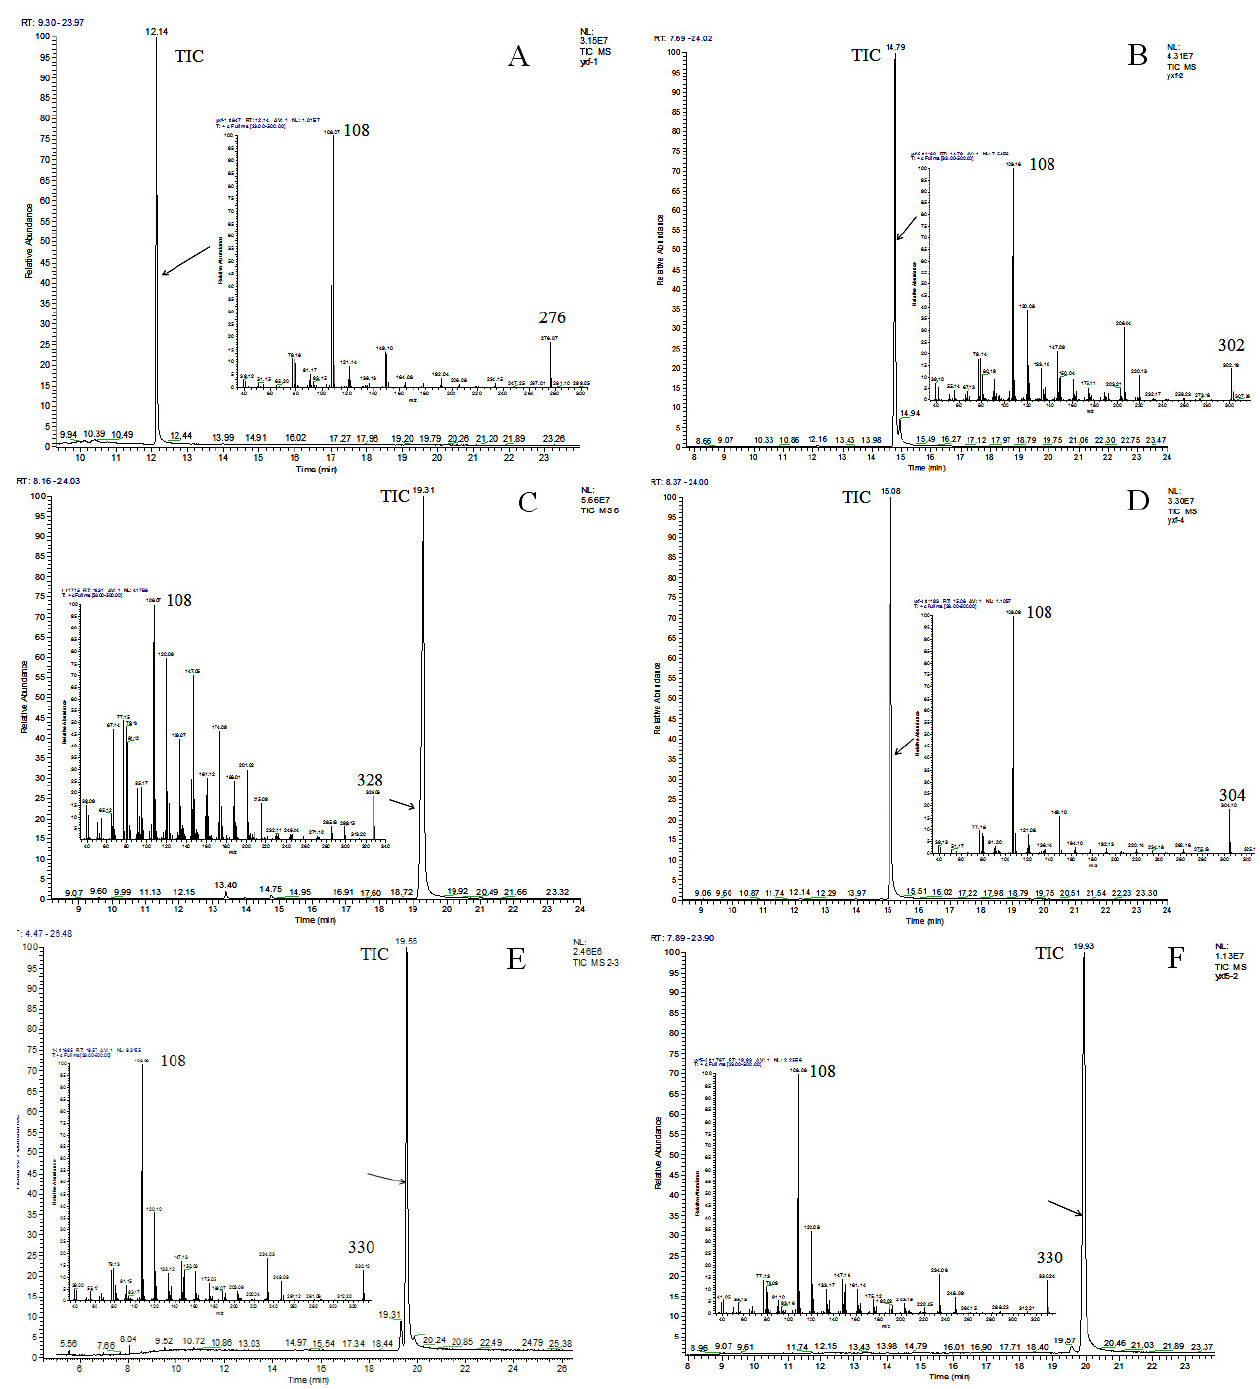
Figure 4. The GC-MS chromatogram and EI mass of compounds G-1 ( A ), G-2 ( B ), G-3 ( C ), G-4 ( D ), G-5 ( E ), and G-6 ( F G-5 ( E ), and G-6 ( F ).